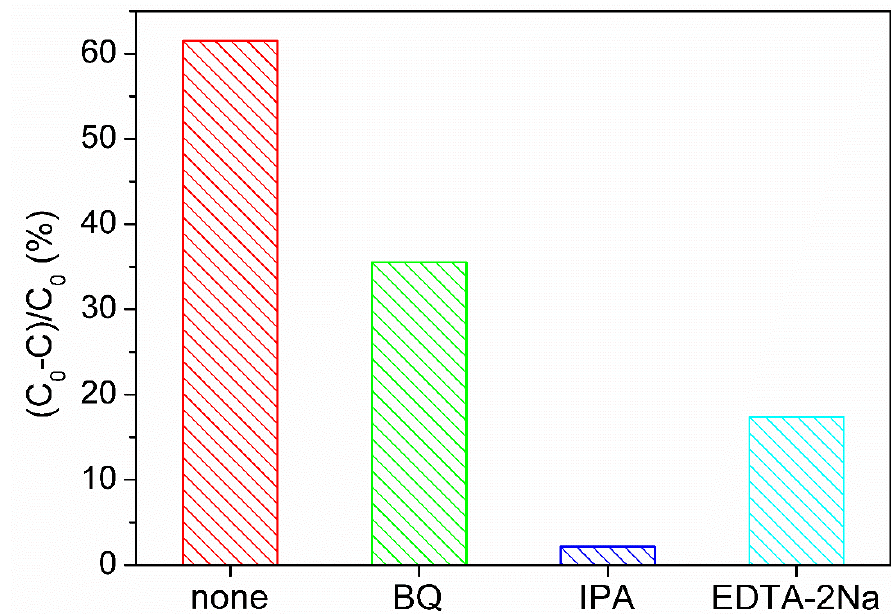
Figure 7. The photocatalytic conversion e ffi ciency of 3 wt% Au / ZnGa 2 O 4 for the degradation of RhB in the presence of di ff erent scavengers (1 mmol L − 1 ), under ultraviolet light irradiation.